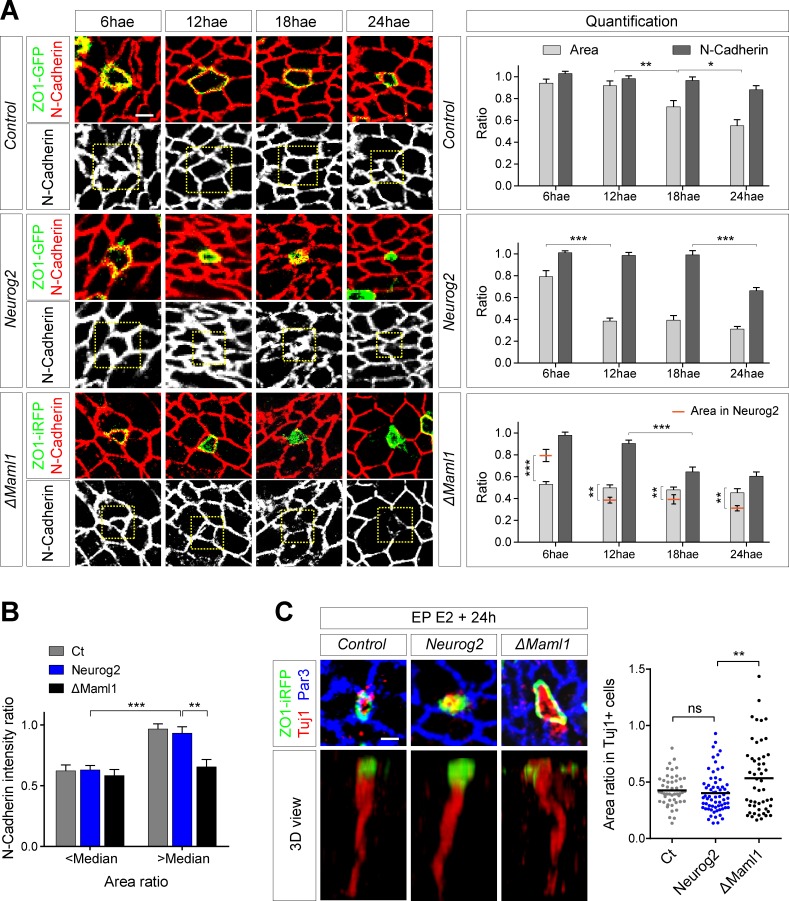
Sequence of events leading to neuron delamination.(A) Left: Apical view of the NT electroporated at E2 with ZO1-GFP/iRFP (green), along with the constructs indicated on the left, and harvested at different hae, followed by an immunostaining for N-Cadherin. The boxed area indicates the cell of interest. Right: Quantification of the apical area ratio (ratio of the area of one transfected cell versus the mean area of four of its close non-transfected neighbors) and N-Cadherin level ratio (ratio of the average pixel intensity within the apical circumference of one transfected cell corrected by the background versus the mean of average pixel intensity of four of its close non-transfected neighbors) at different hae. Data represent mean + SEM. (B) N-Cadherin intensity ratio as a function of apical area ratio at 24 hae. Data were taken from (A). The “median” used as a threshold to discriminate between small and large apical areas corresponds to the median of the control (0.62). **p < 0.01; ***p < 0.001 (one-way ANOVA). (C) Top: Apical view of the NT transfected with ZO1-iRFP (green) along with the indicated constructs and immunostained for Tuj1 (red) and Par3 (blue). Bottom: Three-dimensional view of the cell represented above but showing only the ZO1-iRFP and Tuj1 stainings. Right: Scatterplot of the mean apical area ratio for Tuj1+ cells. Each point represents one apical area ratio calculated as in (A). n = 49, 66, 51 cells collected from five embryos were analyzed for control, Neurog2, and ΔMaml1, respectively. ns, p > 0.05; ***p < 0.001 (Kruskal-Wallis test). Horizontal bars correspond to means. Underlying data are provided in S1 Data. Scale bar represents 2 μm. See also S3 Fig. ΔMaml1, dominant-negative Mastermind-like 1; E, embryonic day; EP, electroporation; GFP, green fluorescent protein; hae, hour after electroporation; iRFP, infrared fluorescent protein; Neurog2, Neurogenin 2; ns, nonsignificant; NT, neural tube; Par3, Partition defective protein 3; ZO1, Zonula Occludens 1.